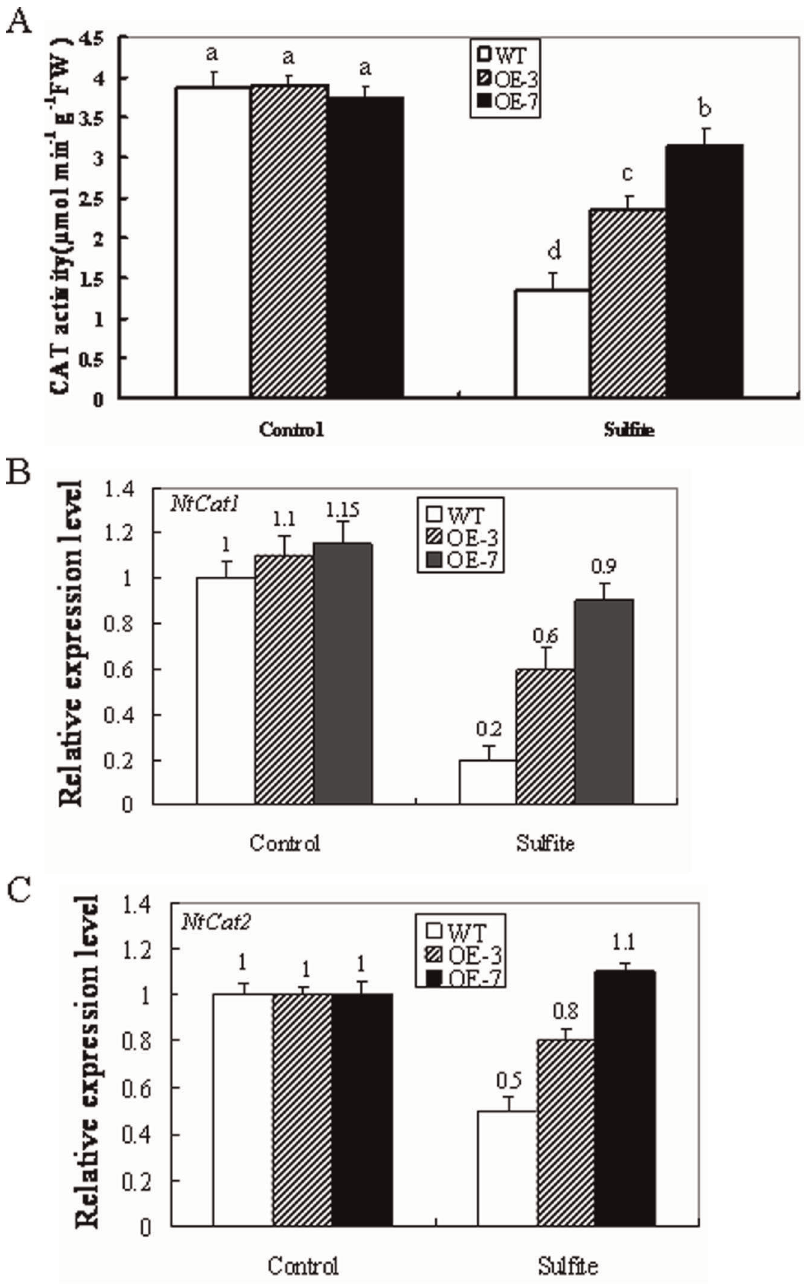
Figure 5. Effects of sulfite on catalase activity and gene expression in wild-type and ZmSO over-expression tobacco plants. (A) Effect of sulfite on total catalase (CAT) activity in wild-type and OE lines (OE-3 and OE-7). Leaf samples from wild-type and OE plants were harvested after 16 h of 5 mM Na 2 SO 3 treatment and total CAT activities were analyzed. Values are means 6 SE (n=6). Means denoted by the same letter did not significantly differ at P , 0.05. (B) Effect of sulfite on transcription levels of Cat1 in wild-type and OE lines (OE-3 and OE-7). (C) Effect of sulfite on transcription levels of Cat2 in wild-type and OE lines (OE-3 and OE-7). In both assays, leaf samples from wild-type and OE plants were harvested after 16 h of 5 mM Na 2 SO 3 treatment and transcriptional expression of Cat1 and Cat2 was detected by qRT-PCR.